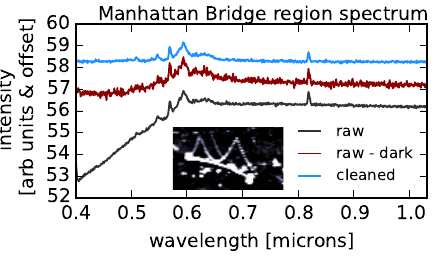
Figure 6. The raw, dark-subtracted (as in Figure 5) and cleaned (using the method described in Section 2) spectra of the Manhattan Bridge region shown in the inset. Large-scale, wavelength-dependent artifacts have been